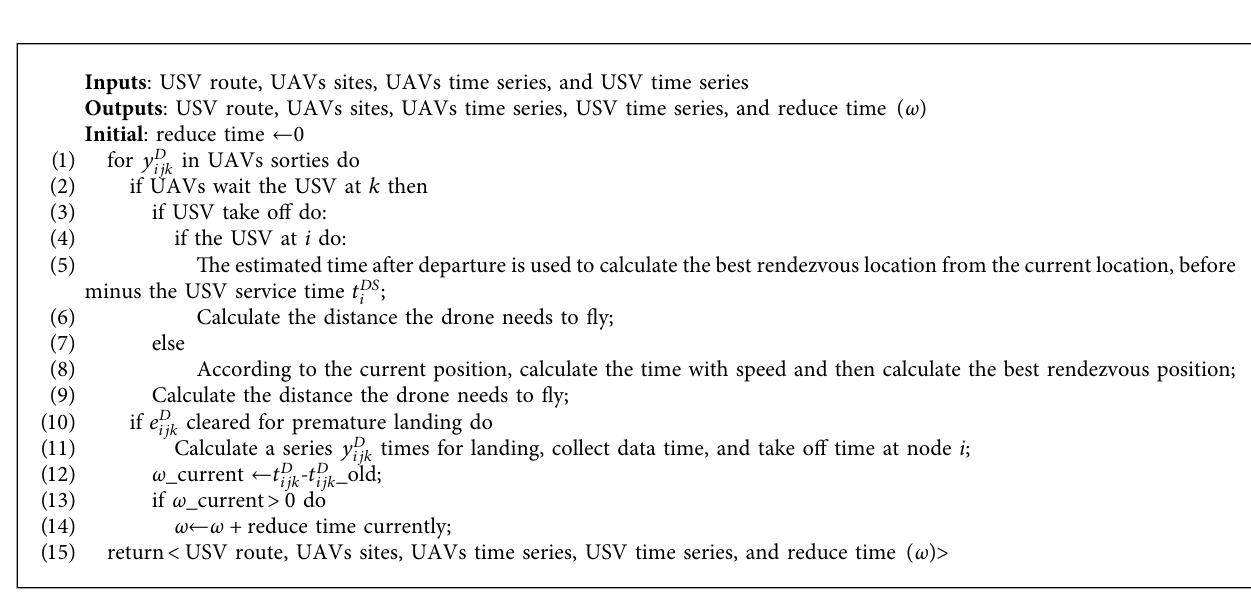
Figure 4: Midfight recovery